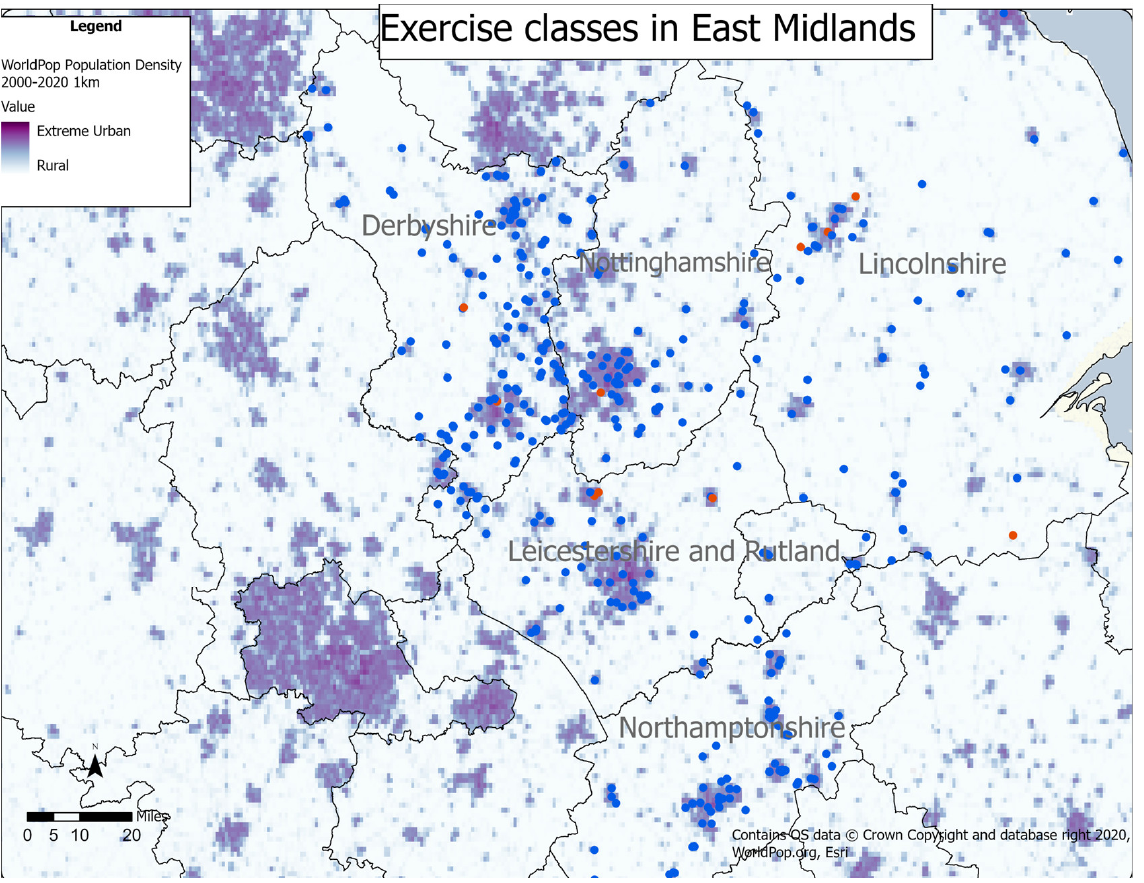
Figure 4. Location of exercise classes in East Midlands, overlaid with population density estimates.